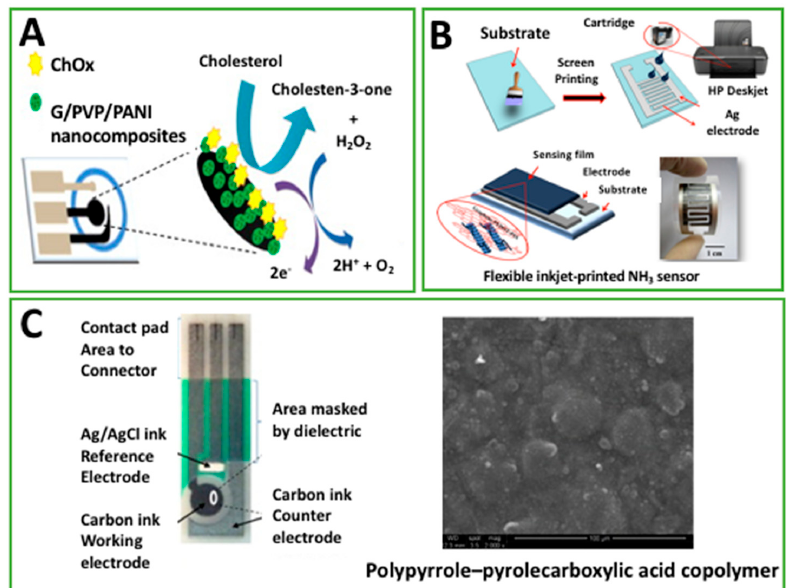
Figure 3. ( A ) The enzymatic reaction between cholesterol and ChOx on Graphene/polyvinylpyrrolidone (PVP)/polyaniline (PANI) modified, paper-based biosensor (permission of [25]; ( B ) schematic diagram of fabrication of a flexible-printed graphene–poly(3,4-ethylenedioxythiophene):poly(styrenesulfonate) (PEDOT:PSS) gas sensor for ammonia detection (permission of [57]); ( C ) Figure 3: the structure of disposable electrochemical printed (DEP) chip used within this work and SEM micrograph of deposited PPy–PPa copolymer film onto carbon ink working electrode (permission of [59]).